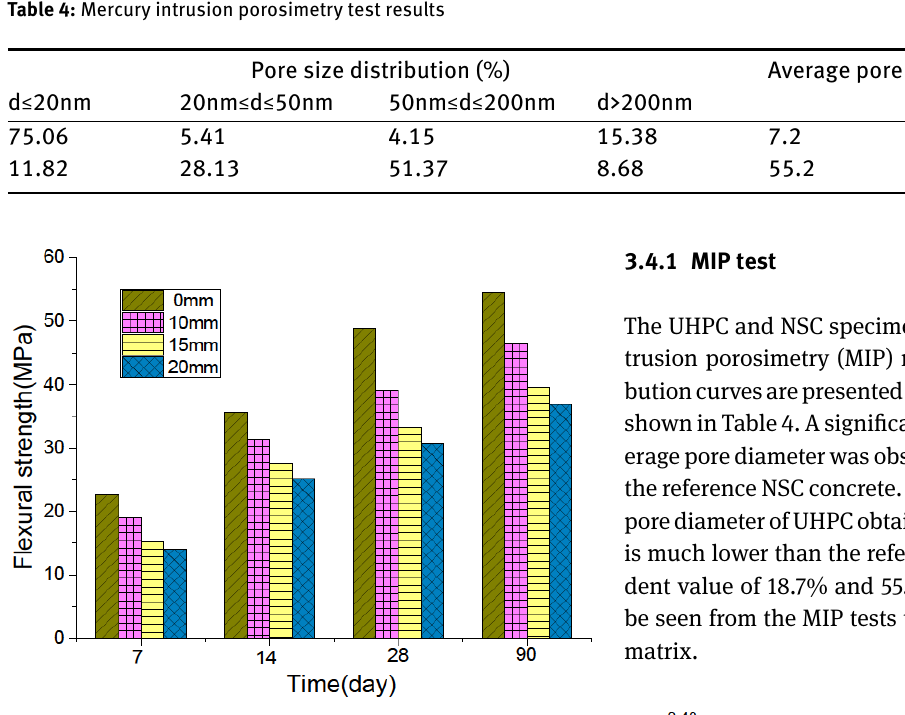
Figure 7: Influence of coarse aggregate size on flexural strength